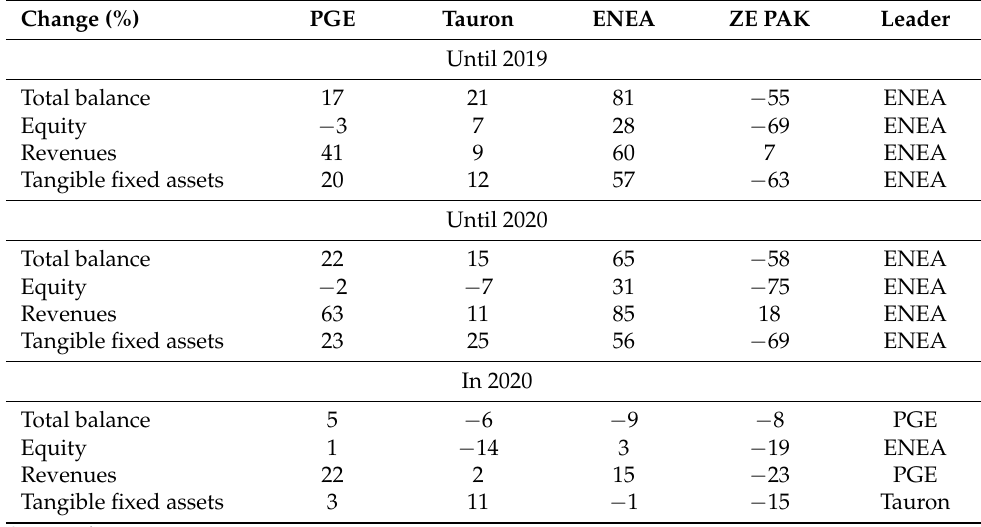
Table 17. Changes in the quantities studied between 2014 and